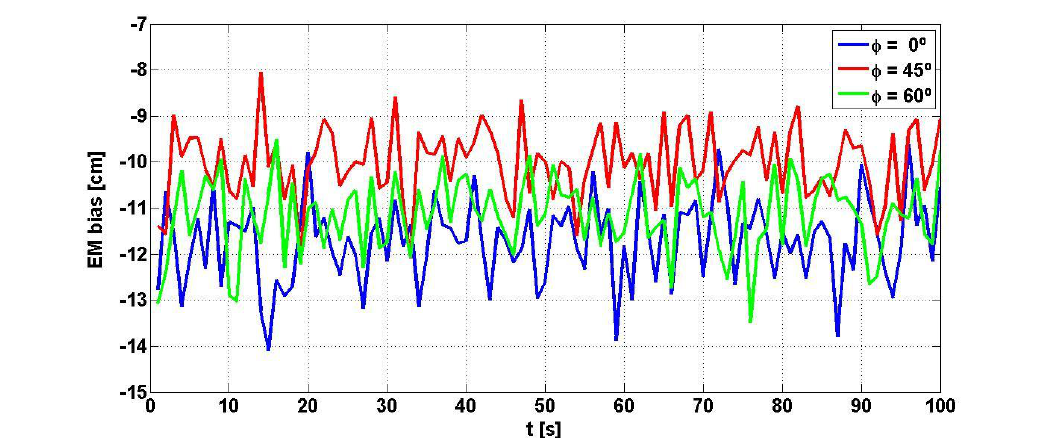
Figure 7. Time-domain evaluation of the EM bias for on incidence/scattering angle of 25° for three different wind directions 0°, 45° and 60°, during 100 s, in 1 s